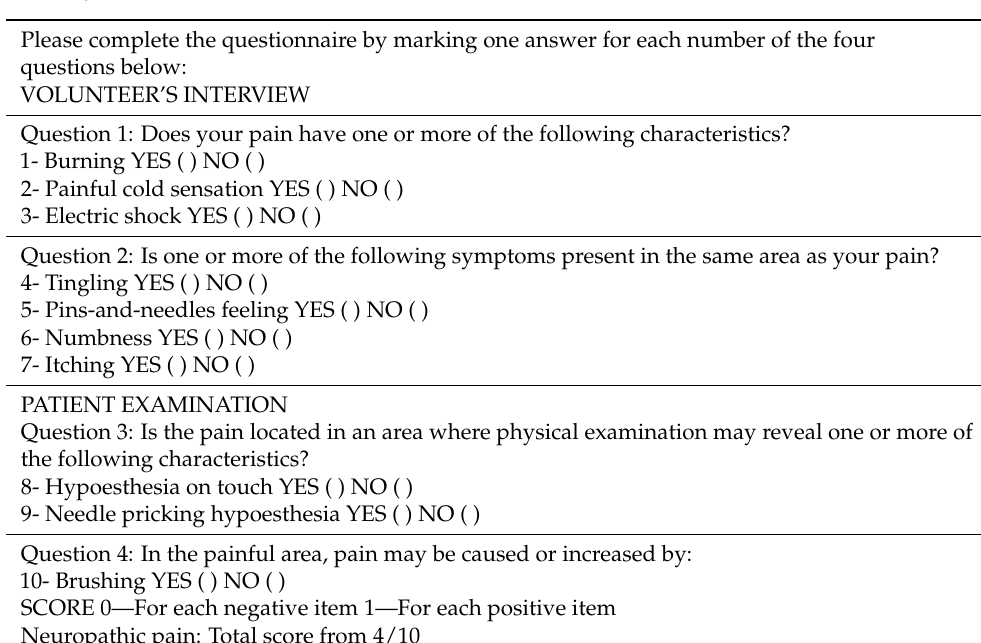
Table 1. DN4 questionnaire administered during the process of including/excluding volunteers in/from the